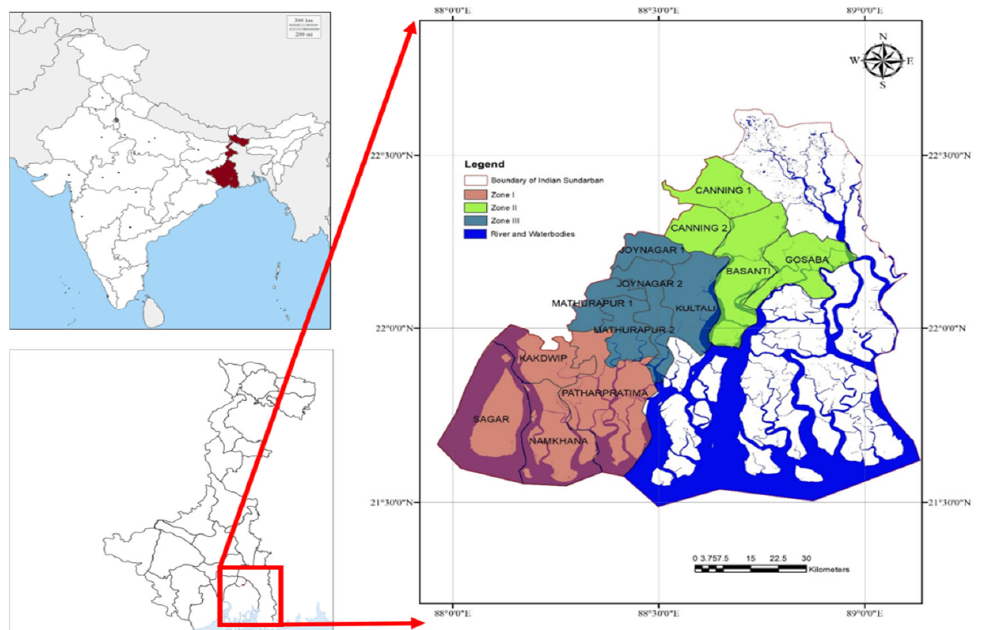
Figure 1. Location map of the study area, the Indian Sundarbans delta. The brown color signifies Zone I, the blue color designates Zone II and the green color represents Zone III.